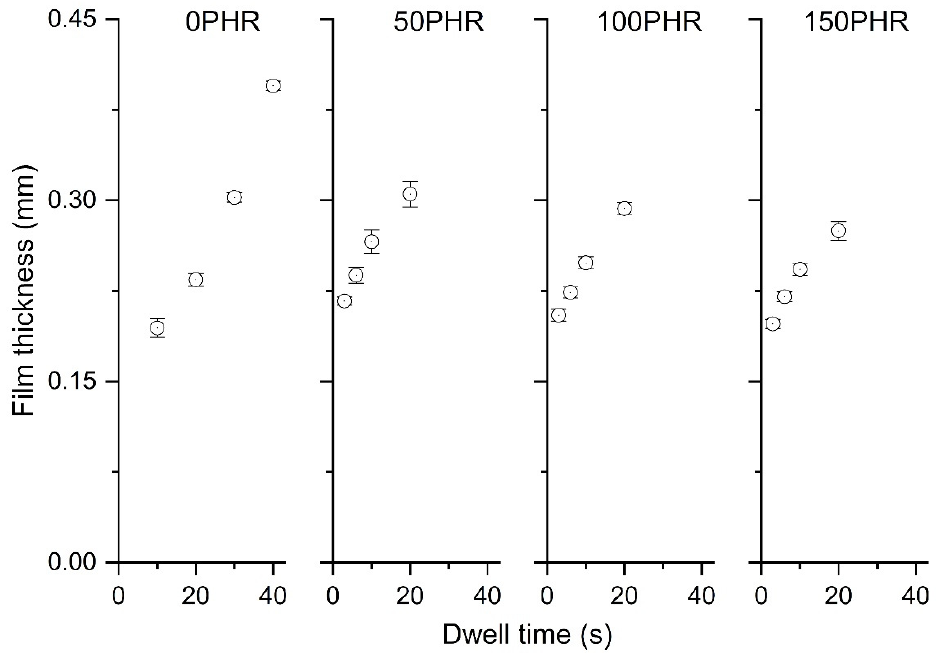
Figure 10. Film thickness vs. dwell time for films produced with 0, 50, 100, and 150 PHR. Results are expressed as means ( n = 12) ± 1 s.d.